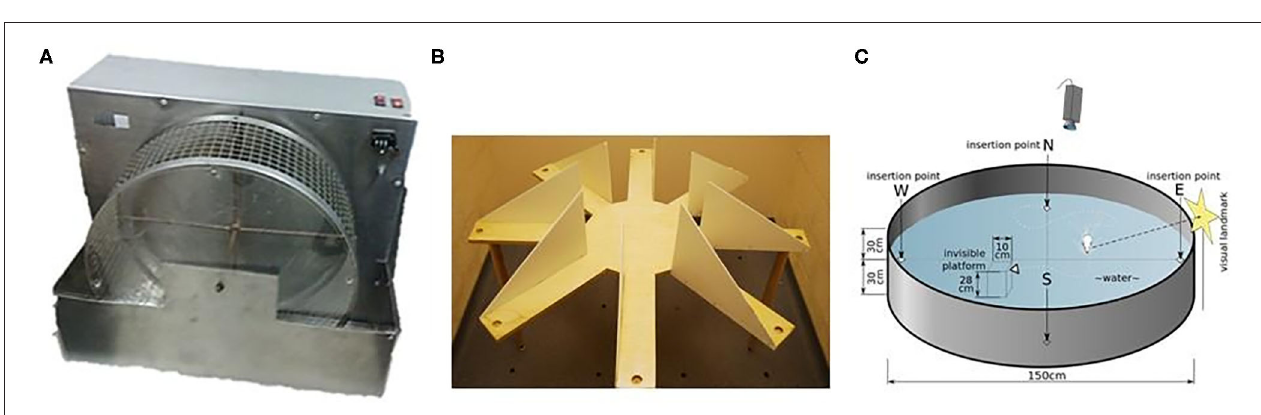
FIGURE 5 | Point like, 1D-like and 2D-like mazes for rodent experiments. Hippocampal place cells follow the point like, 1D-like and 2D structure of the available space. (A) Running wheel. Reproduced from https://peerj.com/articles/2976/ under CC BY-SA 4.0 license. (B) Radial arm maze. Reproduced from https://en. wikipedia.org/wiki/Radial_arm_maze#/media/File:Simple_Radial_Maze under CC BY-SA 3.0 license. (C) Morris water maze. Reproduced from https://en.wikipedia. org/wiki/File:MorrisWaterMaze.svg under CC BY-SA 3.0